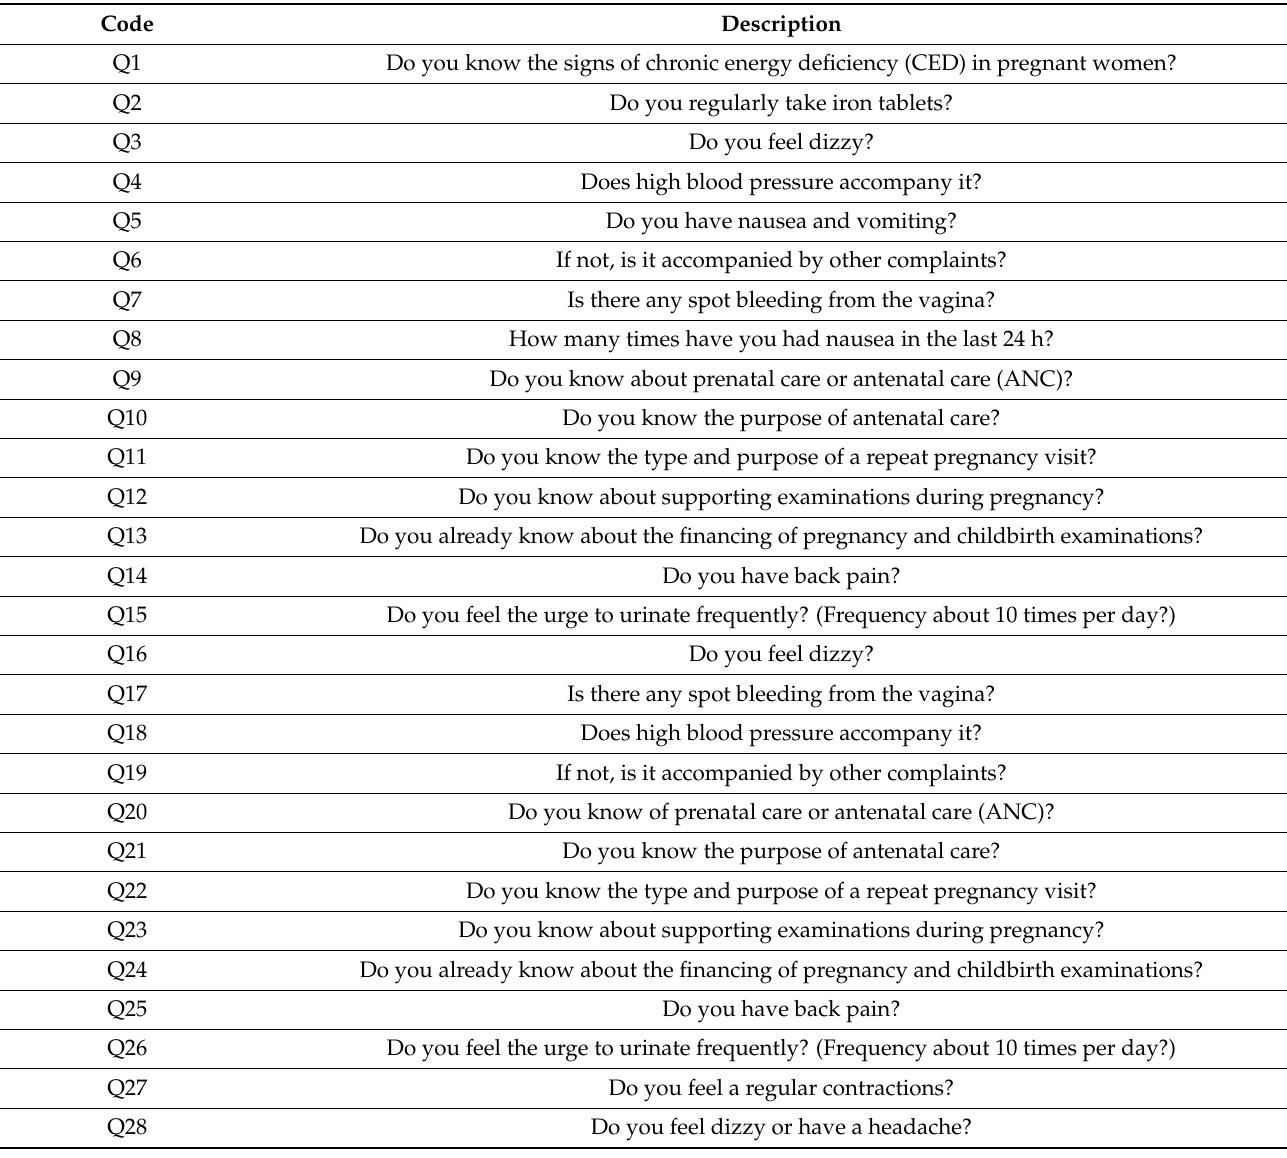
Table A2. The Question List of Decision